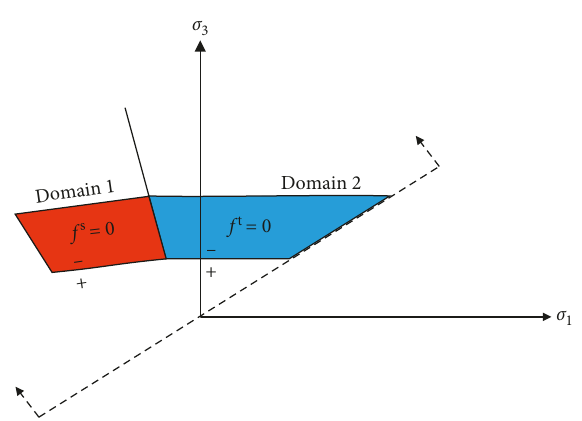
Figure 7: Mohr–Coulomb model: domains used in the definition of the flow rule [26].